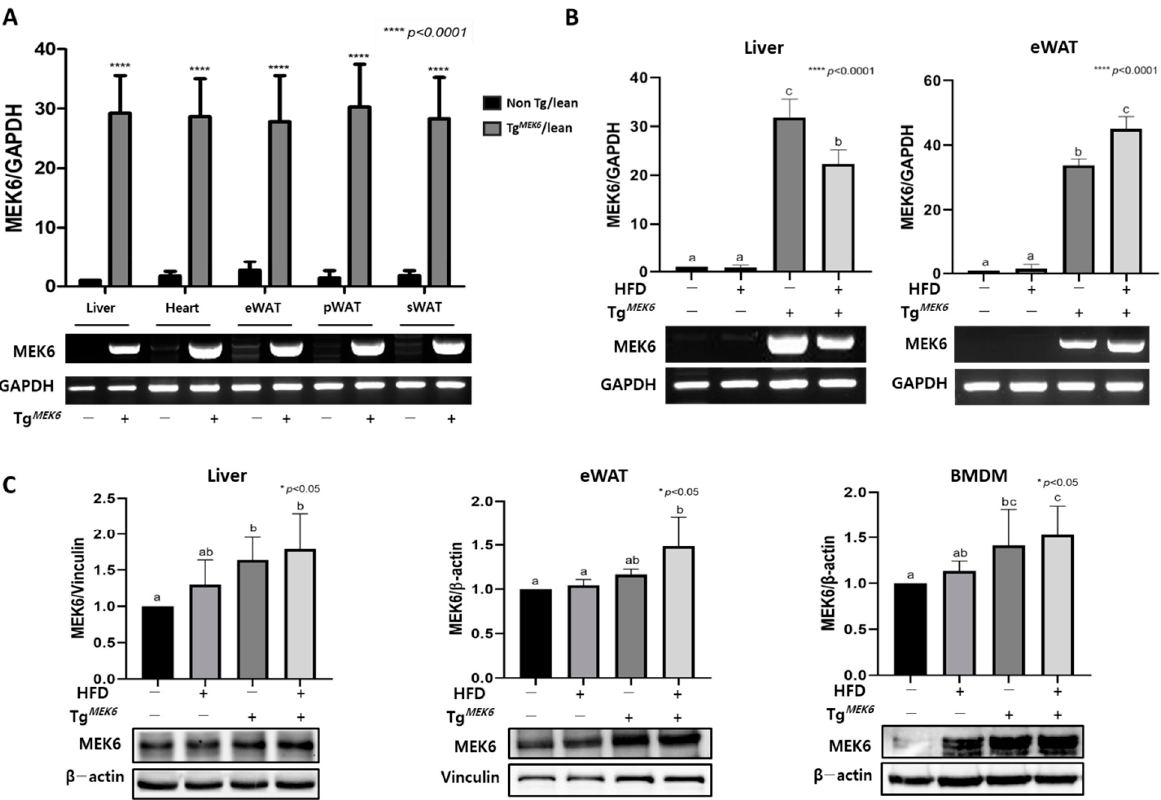
Figure 1. Generation of a mouse model overexpressing MEK6 . ( A ) Relative expression of MEK6 mRNA in the indicated tissues of Tg MEK6 /lean ( n = 10) compared to non-Tg/lean ( n = 10); Liver, Heart, eWAT (Epididymal fat), pWAT (Perirenal fat), sWAT (Subcutaneous fat). ( B ) Relative expression of MEK6 mRNA in Liver and eWAT of non ‐ Tg/lean ( n = 10), non ‐ Tg/DIO ( n = 10), Tg MEK6 /lean ( n = 10) and Tg MEK6 /DIO ( n = 10). ( C ) Expression levels of MEK6 proteins in liver, eWAT and BMDM. Results are expressed as mean ± SD. Data were assessed by Student’s t ‐ test or one ‐ way ANOVA with Duncan’s test (NS, not significant by unpaired t ‐ test. *; p < 0.05, ****; p < 0.0001). Superscript letters (a–c) indicate the significant differences between the groups at p < 0.05. +, treatment or transfection; − , non ‐ treatment or non ‐ transfection.